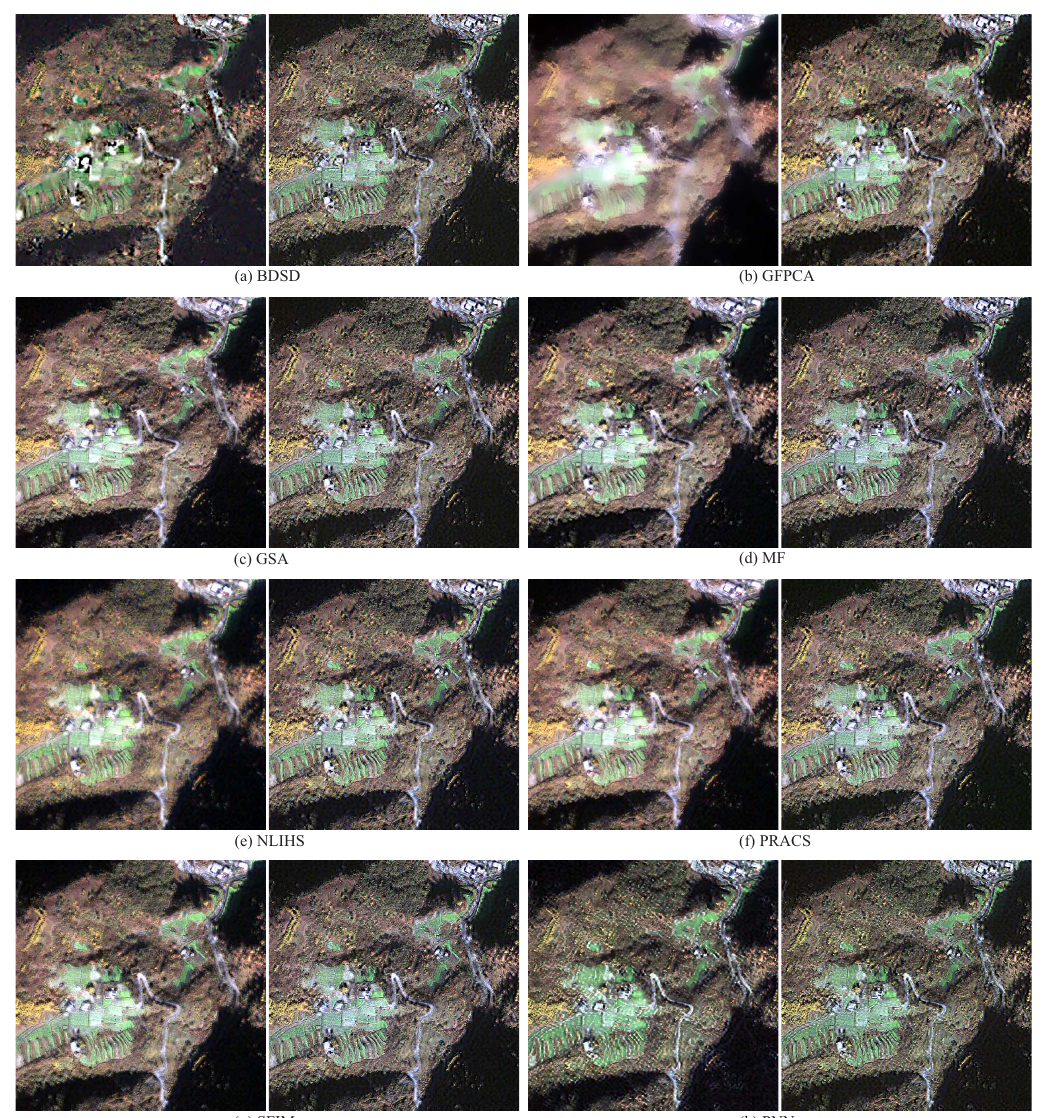
Figure 1. Visual comparison of the fused images obtained by eight methods with and without the proposed EBP as postprocessing on the IKONOS dataset, ( a ) BDSD; ( b ) GFPCA; ( c ) GSA; ( d ) MF; ( e ) NLIHS; ( f ) PRACS; ( g ) SFIM; ( h ) PNN. In contrast, the results with EBP postprocessing (on the right side of each subfigure) have more spatial details and more pleasant colors than those of without EBP (on the left side of each subfigure). Best zoomed in on screen for visual comparison